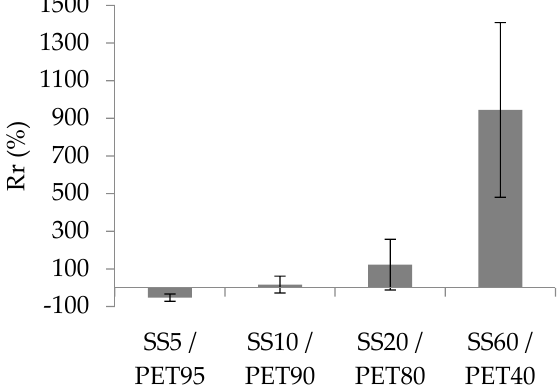
Figure 5. Influence of the implementation of the blended spun yarn in the resin on the yarn’s electrical conductivity.